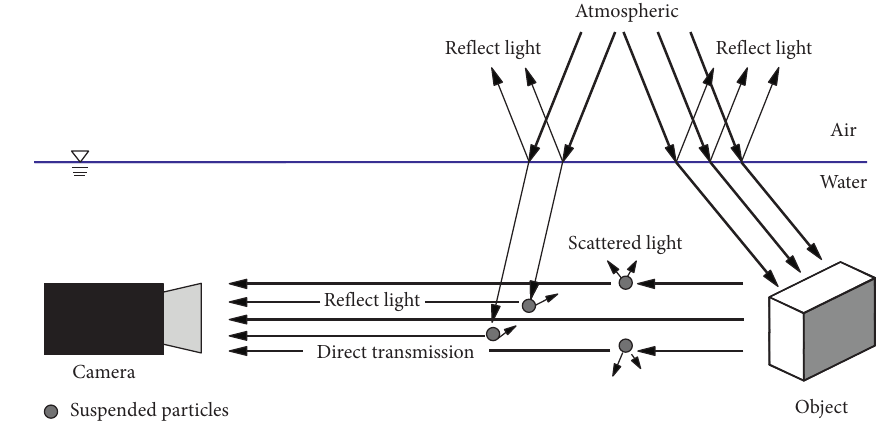
Figure 1: Degradation of light in a medium.